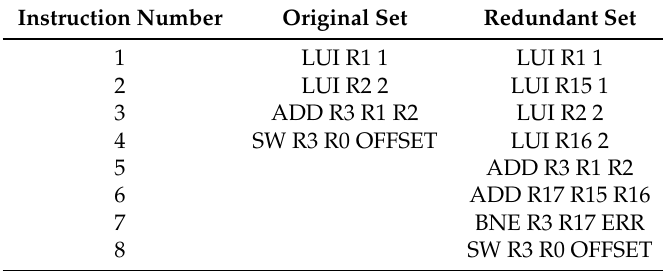
Table 1. Simple software redundancy